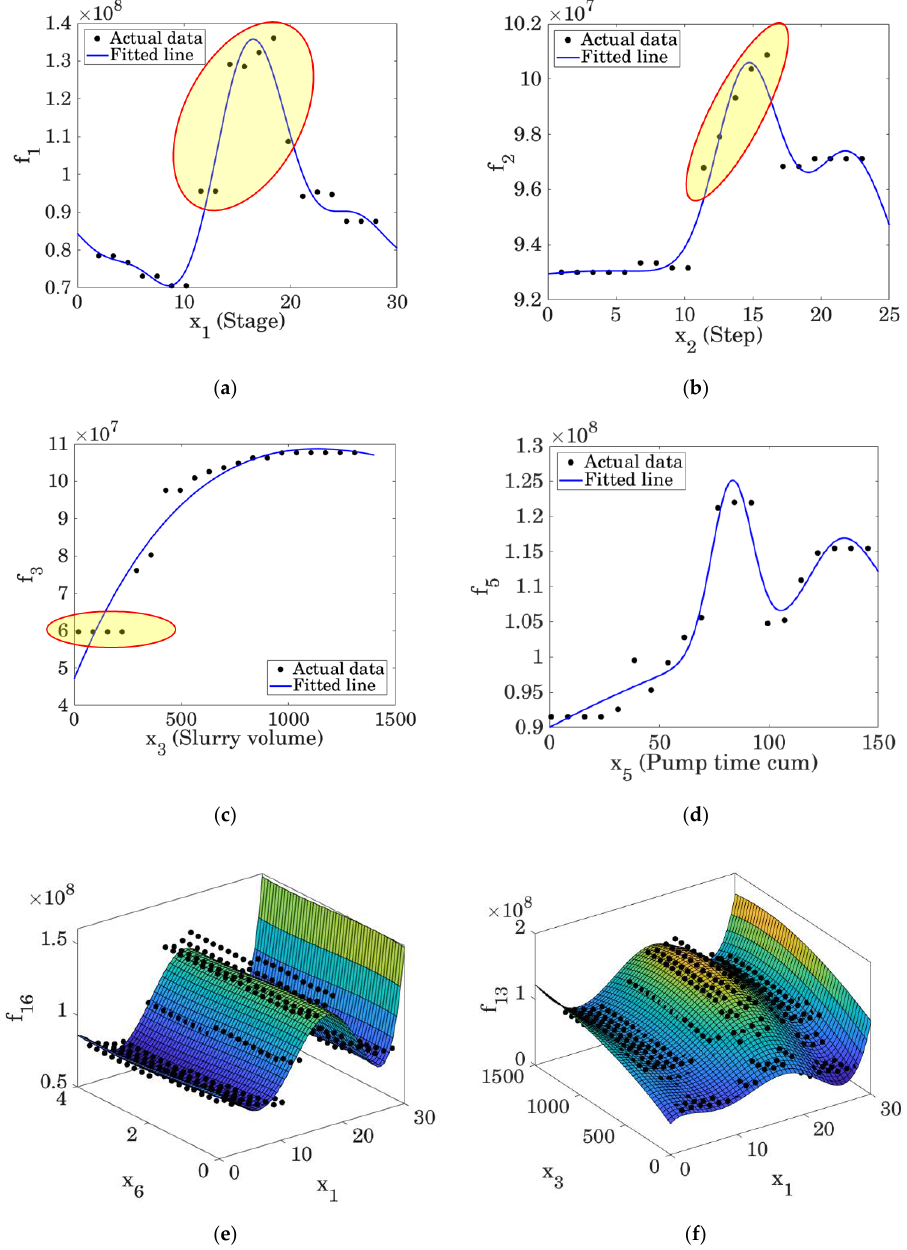
Figure 15. The first- and second-order Sobol functions. f i ( a – d ) and f ij ( e , f ) are the corresponding functions of x i and x ij . This study selected eight input variables for the sensitivity analysis. The variables and their ranges are summarized in Table